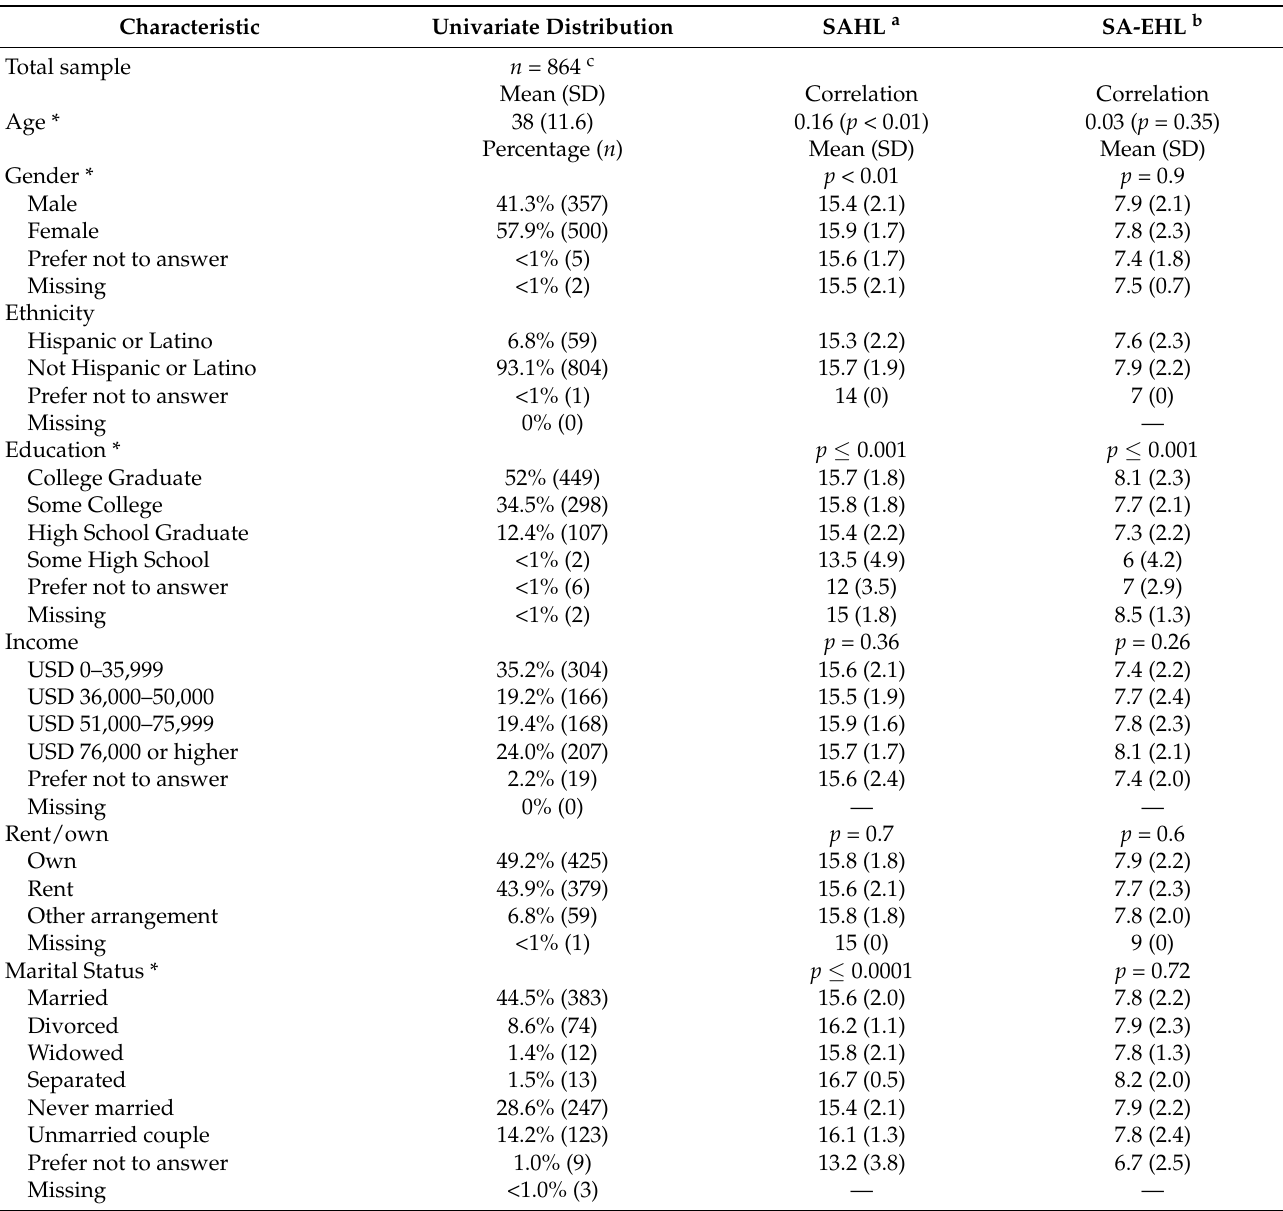
Table 1. Study population demographics. Covariates included age, gender, educational attainment and household